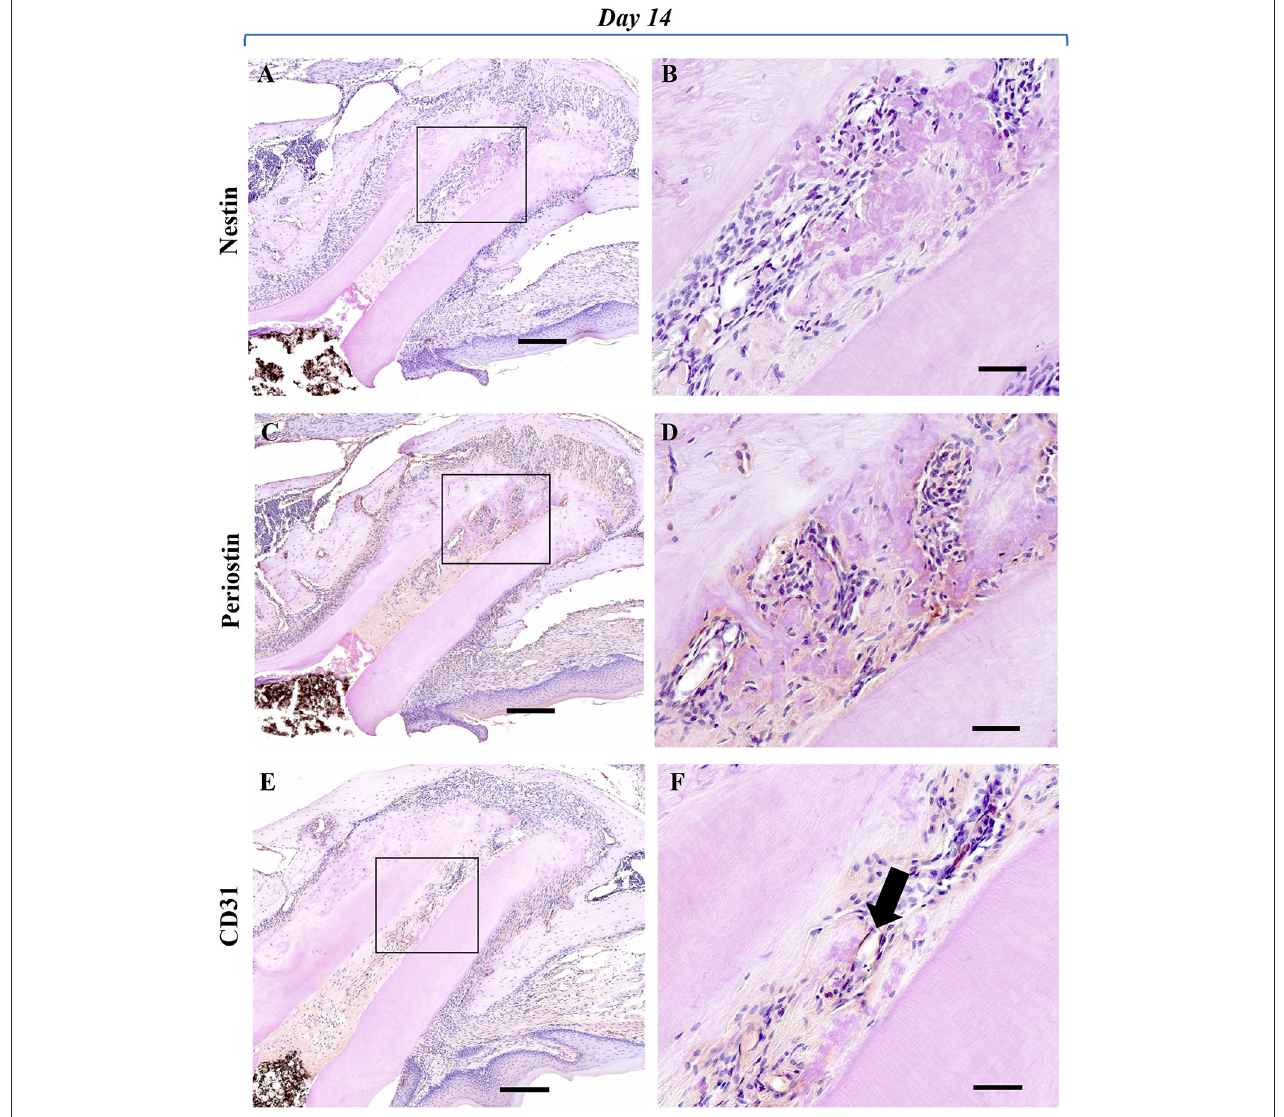
FIGURE 4 | Representative IHC-stained images of the experimental group at 14 days. Nestin: (A,B) ; Periostin: (C,D) ; CD31: (E,F) . (A) No cells showing a nestin-positive reaction were observed in the root canal and periapical tissues. (B) Higher magnification of the black box area in (A). No cells showing nestin-positive reaction were observed around the newly formed mineralized tissue in the root canal. (C) A marked periostin-positive reaction was observed in the PDL region around the mesial root and in the newly formed calcified tissue in the root canal. (D) Higher magnification of the black box area in (C) . In the root canal, a marked periostin-positive reaction was observed around the newly formed mineralized tissue and in cells embedded in the matrix of the cementum-like hard tissue. (E) CD31-positive reaction was observed in the center area of the root canal. (F) Higher magnification of the black box area in (E) . The presence of a new blood vessel with a lumen-like structure showing a CD31-positive reaction (black arrow) was observed at the center area of the root canal (Scale bars = 200 µ m in A, C, and E; scale bars = 50 µ m in B, D, and